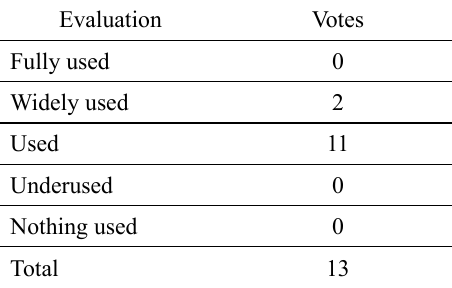
Table 12. Evaluation of the use of e-government in the municipality Evaluation